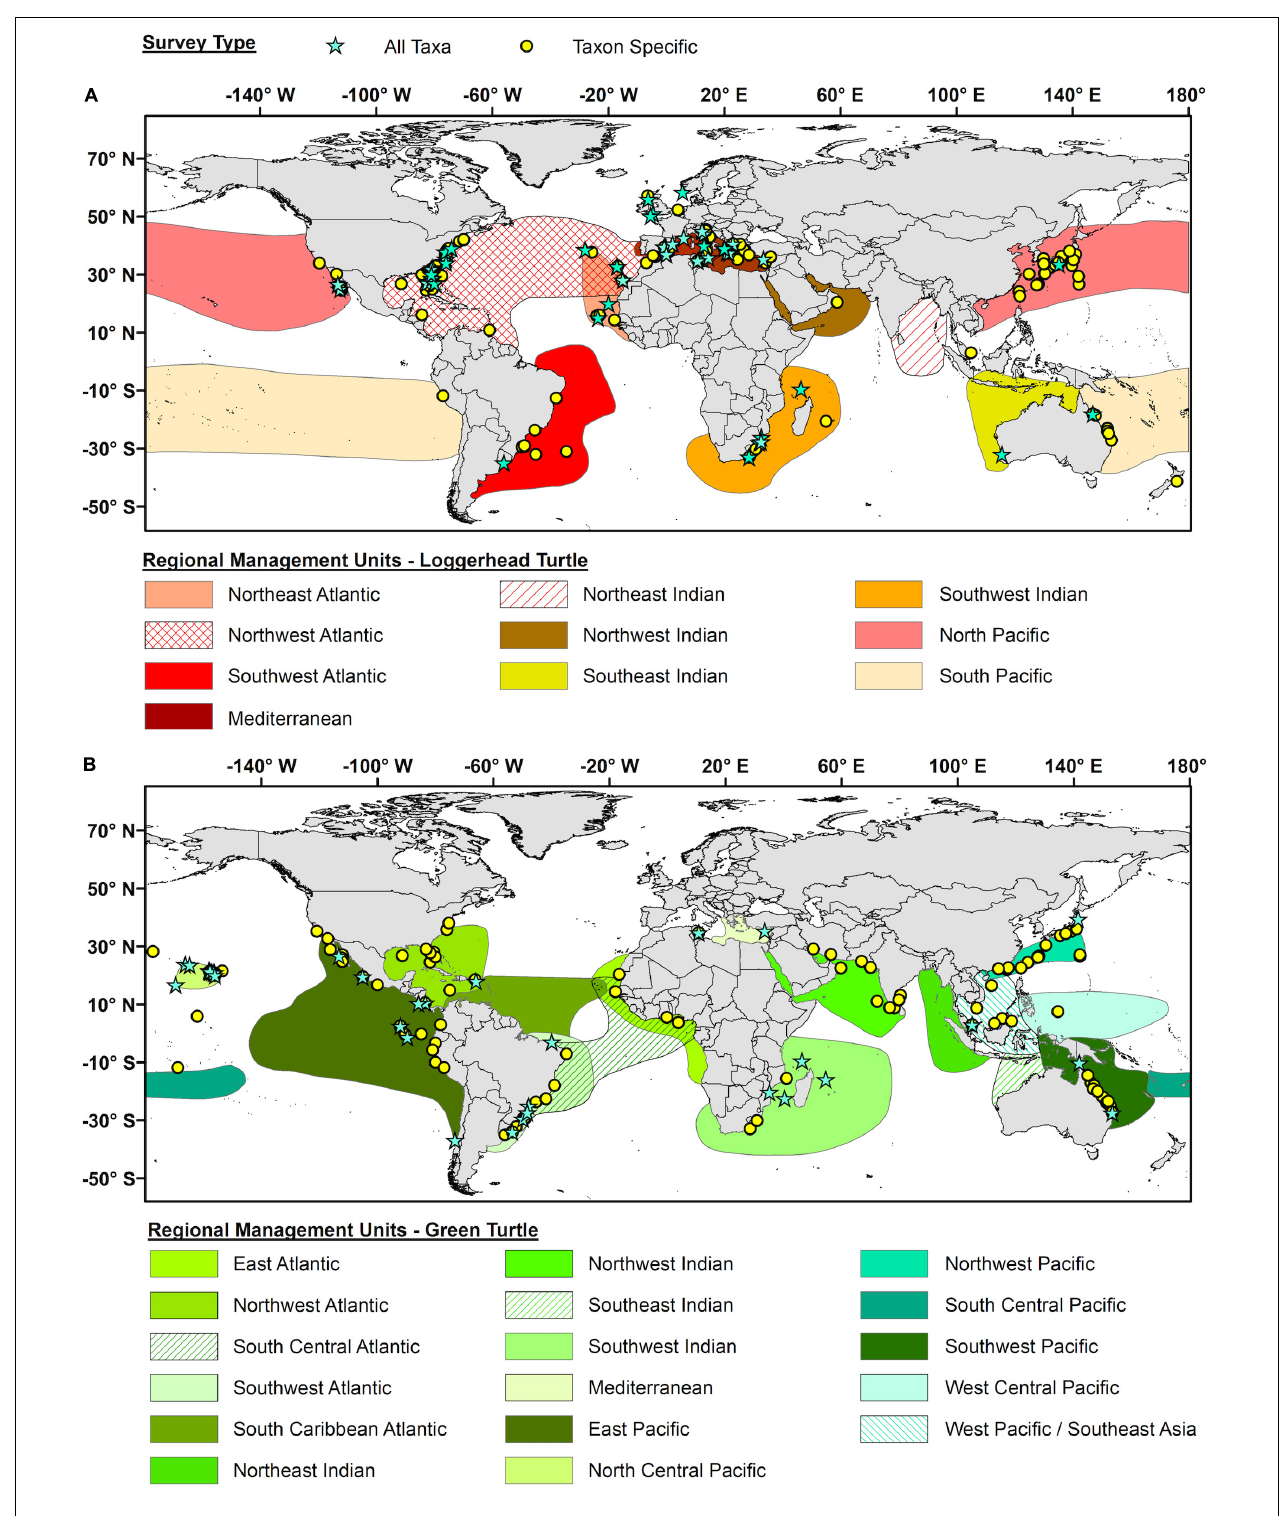
FIGURE 6 | Geographic distribution of all epibiont studies for (A) loggerhead turtles ( Caretta caretta ) and (B) green turtles ( Chelonia mydas ). Blue stars represent studies that report on all potential taxa (All Taxa), while yellow circles represent studies that only focus on specific taxa (Taxon Specific). The geographic outlines for each Regional Management Unit as represented by differentially colored polygons (based on Wallace et al., 2010).